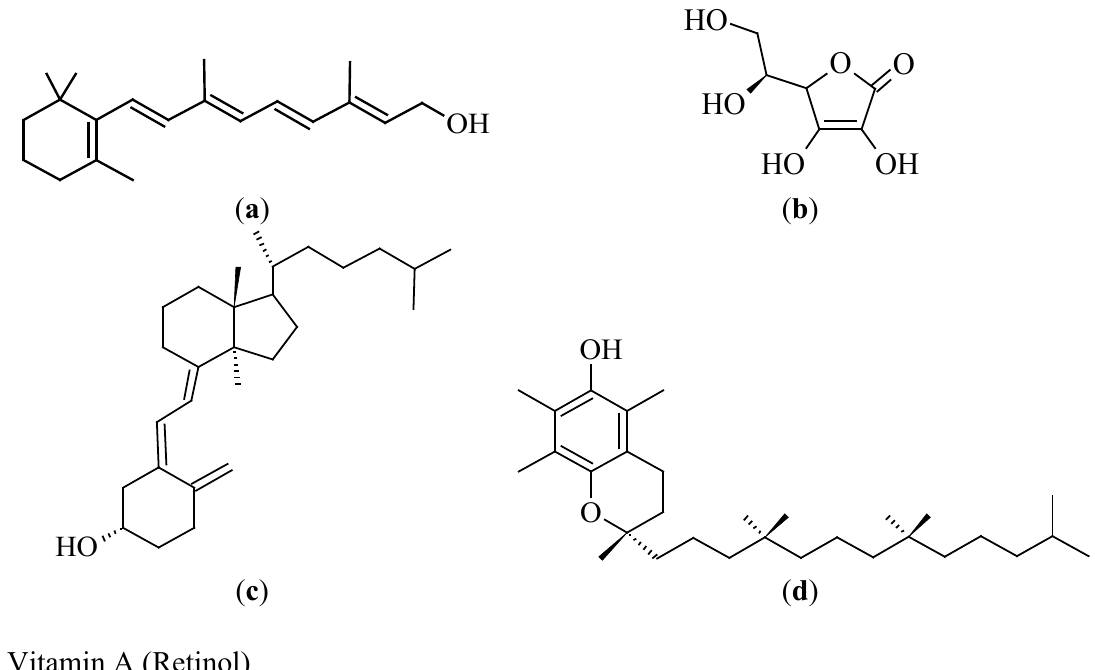
Figure 4. Chemical structures of ( a ) vitamin A, ( b ) vitamin C, ( c ) vitamin D3 and ( d ) vitamin E (α